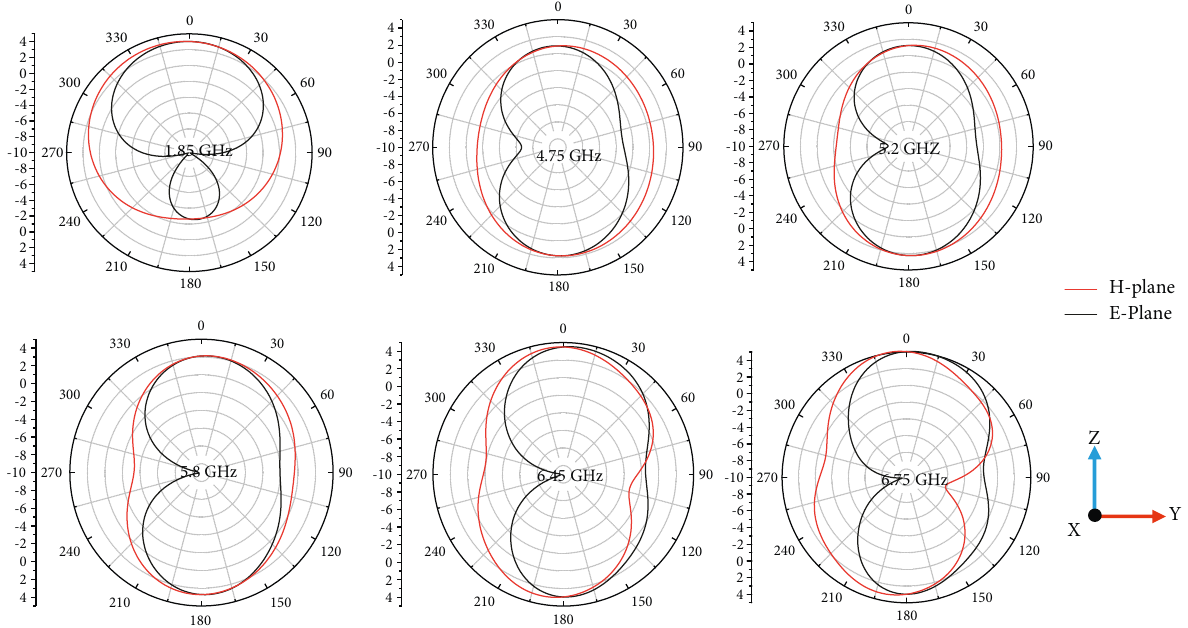
Figure 7: Radiation Pattern of the proposed OBS